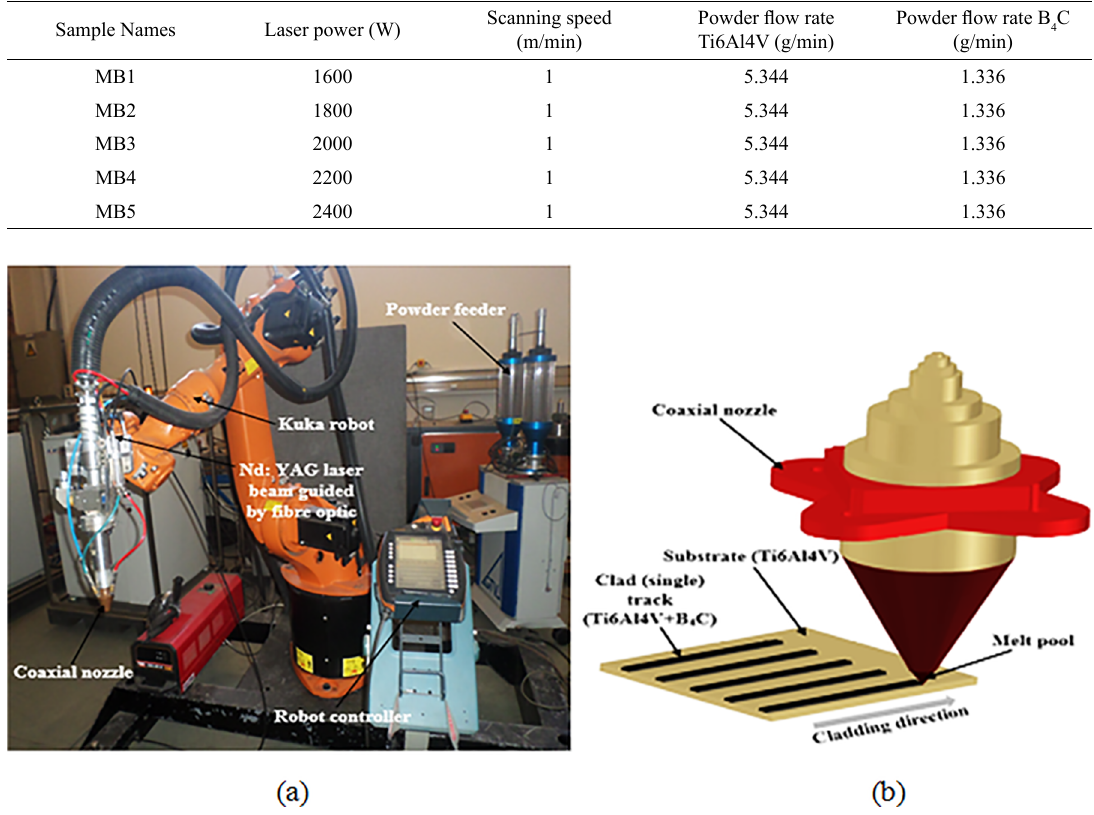
Figure 1. (a) Experimental setup, (b) Schematic diagram of LMD process.